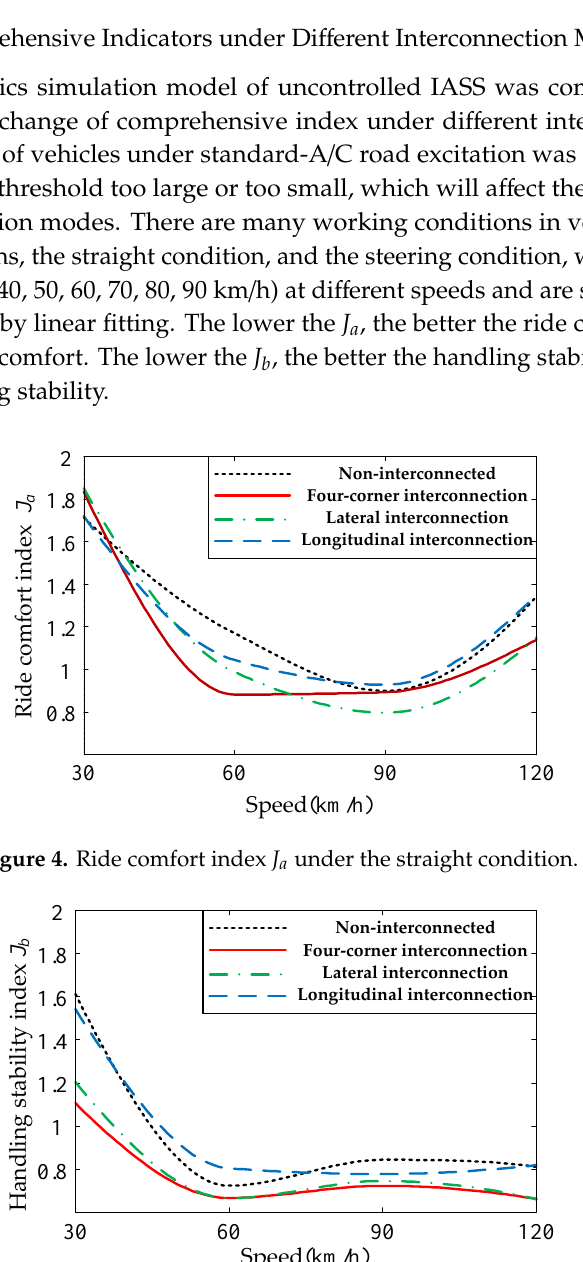
Figure 6. Ride comfort index J a under the steering condition.